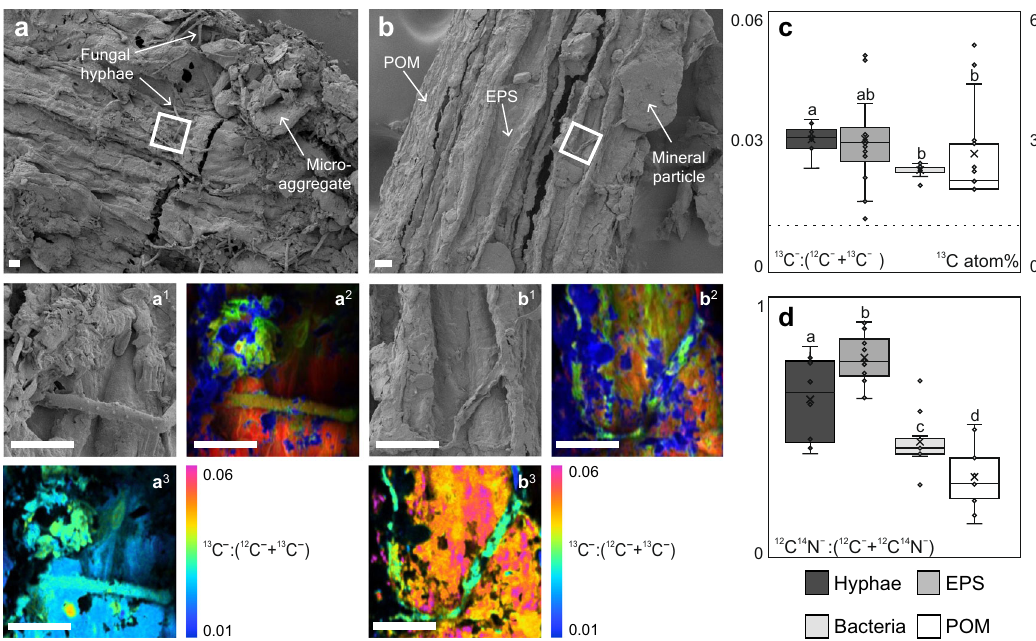
Fig. 7 High 13 C enrichment detected in fungal hyphae and EPS based on NanoSIMS imaging. Scanning electron microscopy (SEM) images of 13 C-enriched maize litter incubated in microcosms and isolated as particulate organic matter (POM) in ( a ) coarse-textured and ( b ) fi ne-textured soil. Similar images were obtained from at least 10 independent locations in each soil texture. a 1 / b 1 SEM micrographs of measurement spots in ( a 1 ) coarse-textured and ( b 1 ) fi ne- textured soil, which was later analyzed by nano-scale secondary ion mass spectrometry (NanoSIMS). In each soil texture, at least fi ve NanoSIMS measurements were conducted at independent locations on the POM fragments with similar results. a 2 / b 2 NanoSIMS composite images displayed as RGB (Red = 12 C − , Green = 12 C 14 N − and Blue = 16 O − ). a 3 / b 3 NanoSIMS hue-saturation intensity (HIS) images displaying the 13 C − :( 12 C + 13 C − ) isotope ratios of POM, fungal hyphae, and extracellular polymeric substances (EPS) in the coarse-textured and fi ne-textured soil. Here the enrichment level is displayed as HIS images with a color scale ranging from natural abundance (0.01) in blue to high enrichment (0.06) in purple. Scale bars = 10 µ m. c Boxplots of 13 C − :( 12 C − + 13 C − ) isotope ratios and d 12 C 14 N − :( 12 C − + 12 C 14 N − ) ratios of hyphae ( n = 8), EPS ( n = 16), bacteria ( n = 10), and POM ( n = 13) in both textures obtained by NanoSIMS. The regions of interest were selected manually on continuous fragments of hyphae, individual bacteria, patches of EPS, and exposed POM surfaces. Box plots indicate medians (line) and means (x), where the fi rst (Q1) and third (Q3) quartile are represented by the lower, respectively upper bounds of the box. Error bars represent the data range, bounded to 1.5×(Q3-Q1) and individual data points are noted as dots. The natural abundance of 13 C is indicated by the hatched line. Signi fi cant differences ( P <0.05) between the four groups are indicated by lowercase